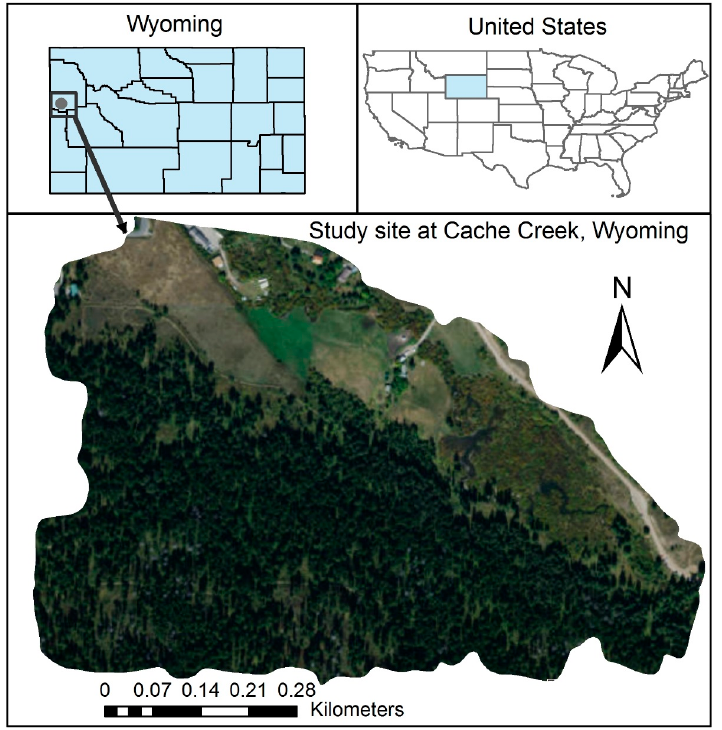
Figure 1. Study Area at Cache Creek, Wyoming, United States of America.